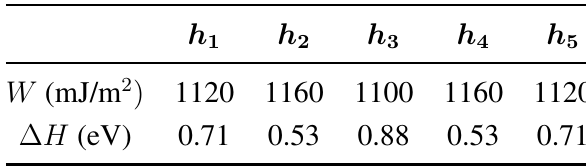
Table 3. Work of adhesion and formation energy for the interfaces without one atom of